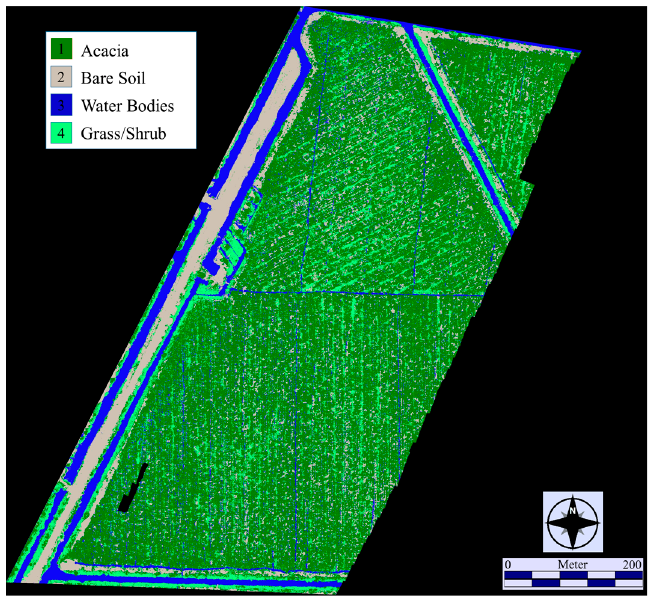
Figure 8. Land use/land cover (LULC) map of the compartment area, developed using RGB and multispectral data observed from the fixed-wing UAS using the multilayer-perceptron (MLP) method.